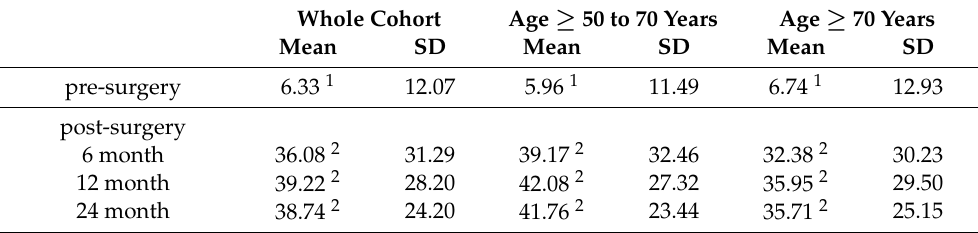
Table 2. Speech perception improves in the entire cohort and age subgroups after implantation. Speech perception in quiet was measured with the Freiburg monosyllabic test (FMT) at 65 dB SPL (sound pressure level). SD = standard deviation. “ 1 ” and “ 2 ” indicate significant differences between respective variables compared to their values per Wilcoxon signed-rank test. p ≤